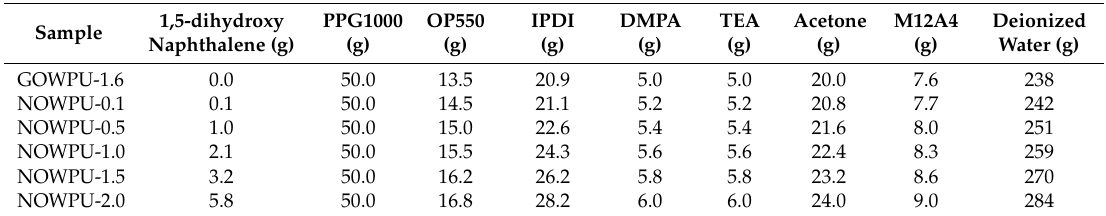
Table 1. Formulation of multifunctional two-component waterborne polyurethanes with fluorescence and flame retardancy